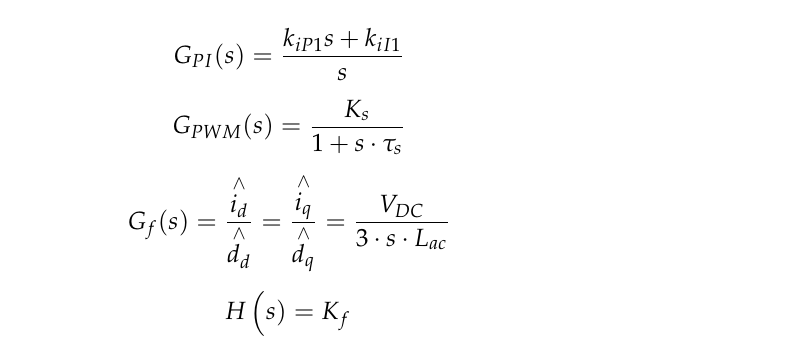
Figure 6. Control structure of active current in DC/AC converter.